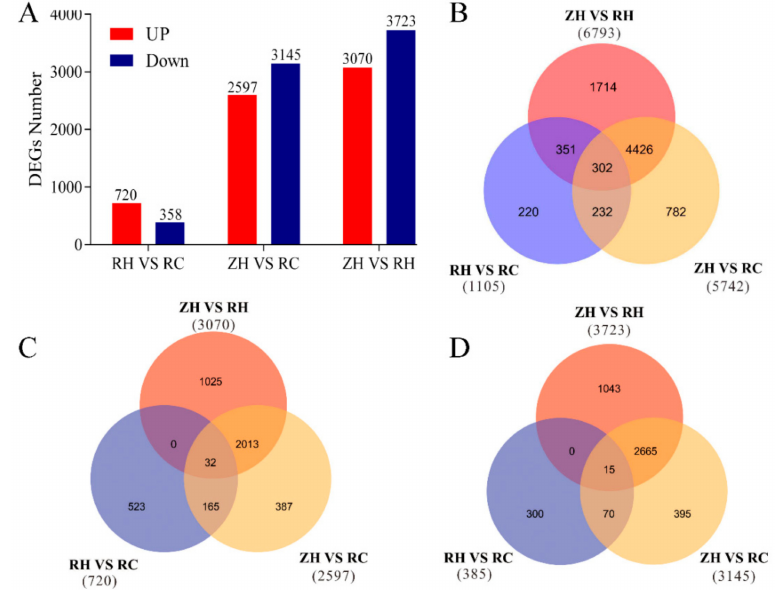
Figure 4. Transcriptome data di ff erential gene numbers and Venn diagram. ( A ) For the RNA-seq database, the number of all genes and the number of up / down-regulated genes in di ff erent periods and treatments. Up-regulated numbers are shown in red, while the number of down-regulated genes is shown in blue. ( B ) Venn diagram of the DEGs in di ff erent comparisons. The numbers indicate unique and common DEGs in three replicates for di ff erent comparisons. ( C ) Venn diagram of the up-regulated genes in di ff erent comparisons. ( D ) Venn diagram of the down-regulated genes in di ff erent